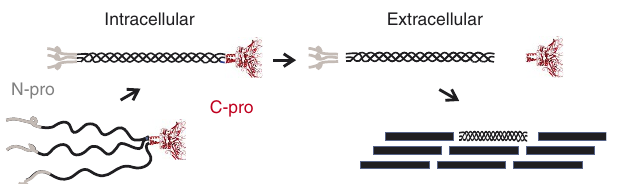
Figure 1 | Roles of the procollagen C-propeptides. Trimerization of the procollagen C-propeptides initiates intracellular assembly of the procollagen molecule while extracellular proteolytic cleavage of the N- and C-propeptides controls collagen fibril formation.